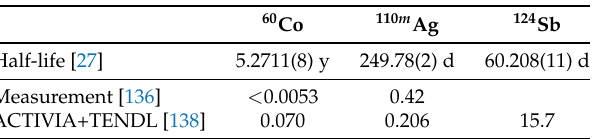
Table 3. Rates of production at sea level of long-lived radioisotopes deduced from measured cross sections for TeO 2 in Ref. [136] and from calculations for natural tellurium in Ref. [138] (see text). All numbers are expressed in